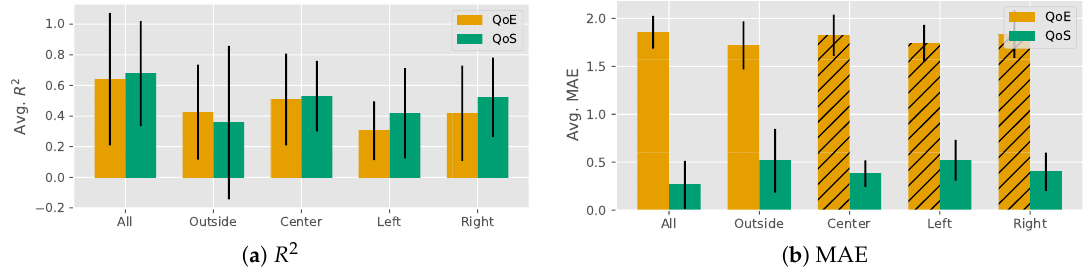
Figure 4. Overview of the EEG data-based results for individual users and electrode positions for the QoE/QoS predictions based on